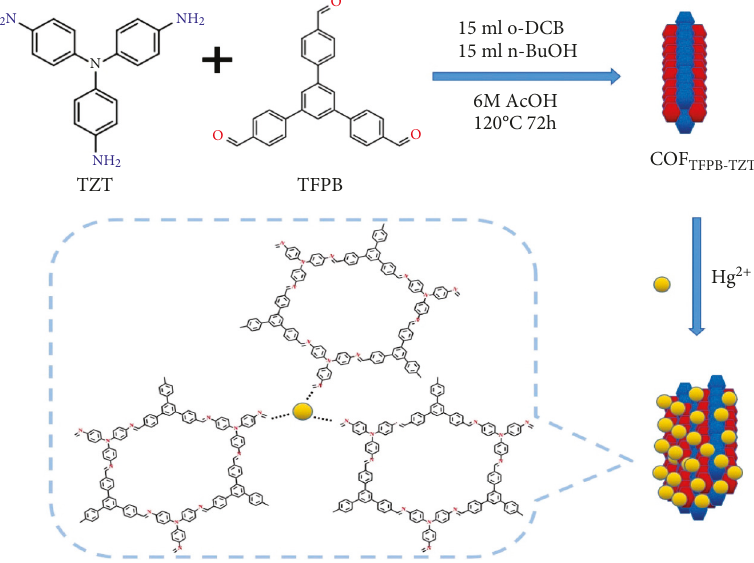
Scheme 1: Schematic illustration of the response process of the